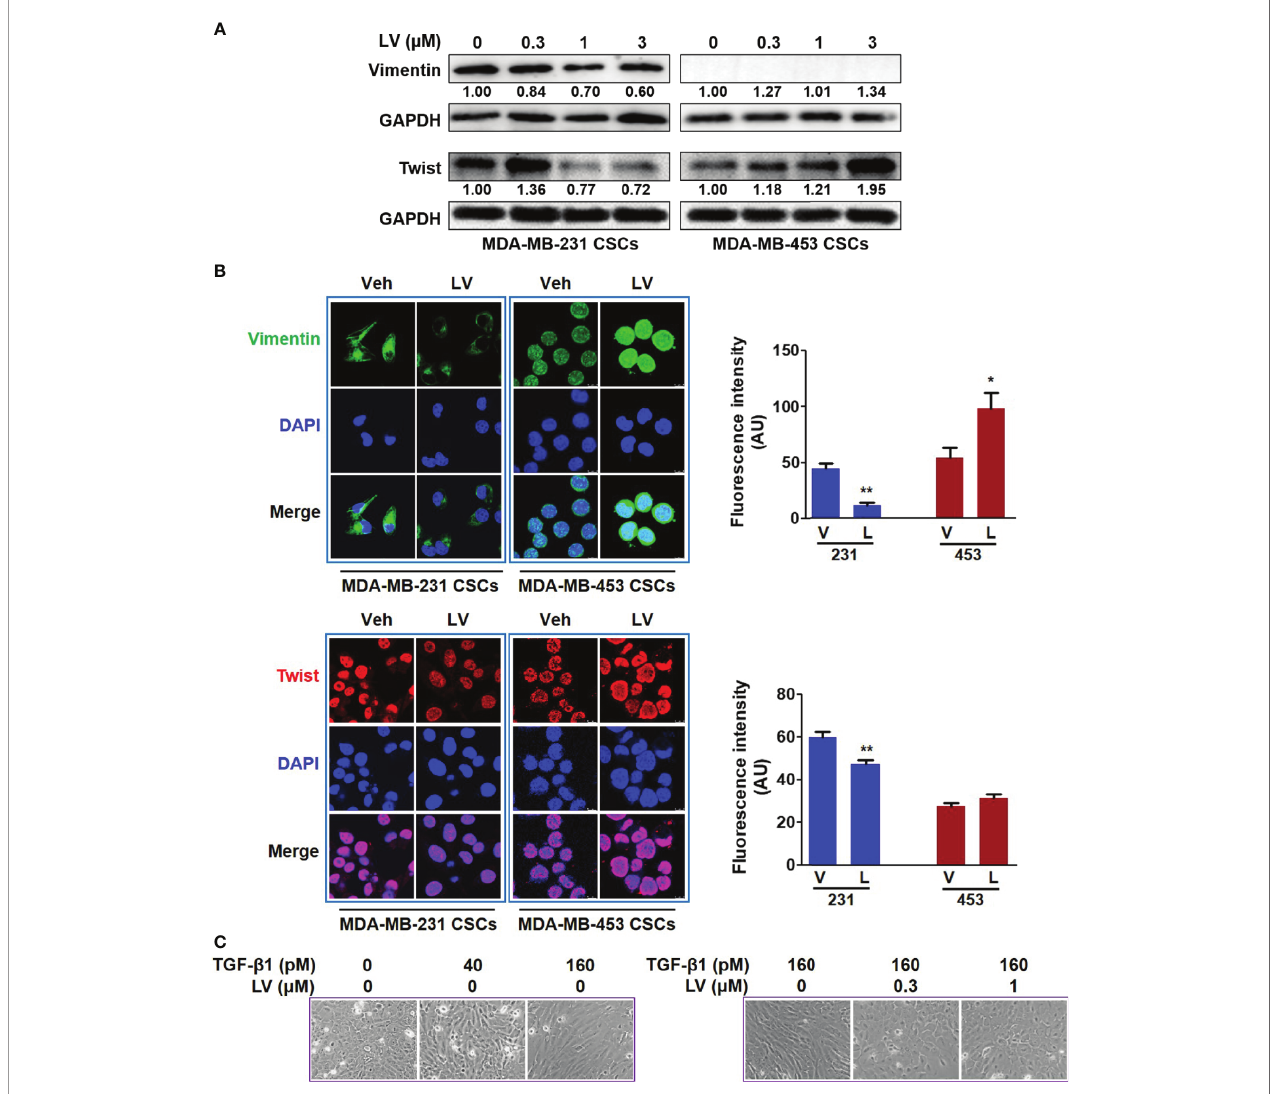
FIGURE 2 | Lovastatin inhibits EMT of TNBC CSCs in vitro . MDA-MB-231 CSCs and MDA-MB-453 CSCs were treated with lovastatin or vehicle for 48 h and the protein levels of Vimentin and Twist were analyzed by western blot analysis (A) . Representative confocal images immuno fl uorescence staining of Vimentin (green) and Twist (red) on MDA-MB-231 CSCs treated in a similar way as in (A) . Nuclei were stained with 4 ′ , 6-diamidino-2-phenylindole (DAPI) (blue). Original magni fi cation: 63×. Right, quanti fi cation of immuno fl uorescence intensity (B) . MCF10A cells were cultured for 7 days with or without different concentrations of TGF- b 1 and/or lovastatin, morphological changes were observed by microscopic examination. Original magni fi cation: 200× (C) . * P < 0.05, ** P < 0.01, compared with control; V or Veh, vehicle; L or LV, lovastatin; AU, arbitrary unit.